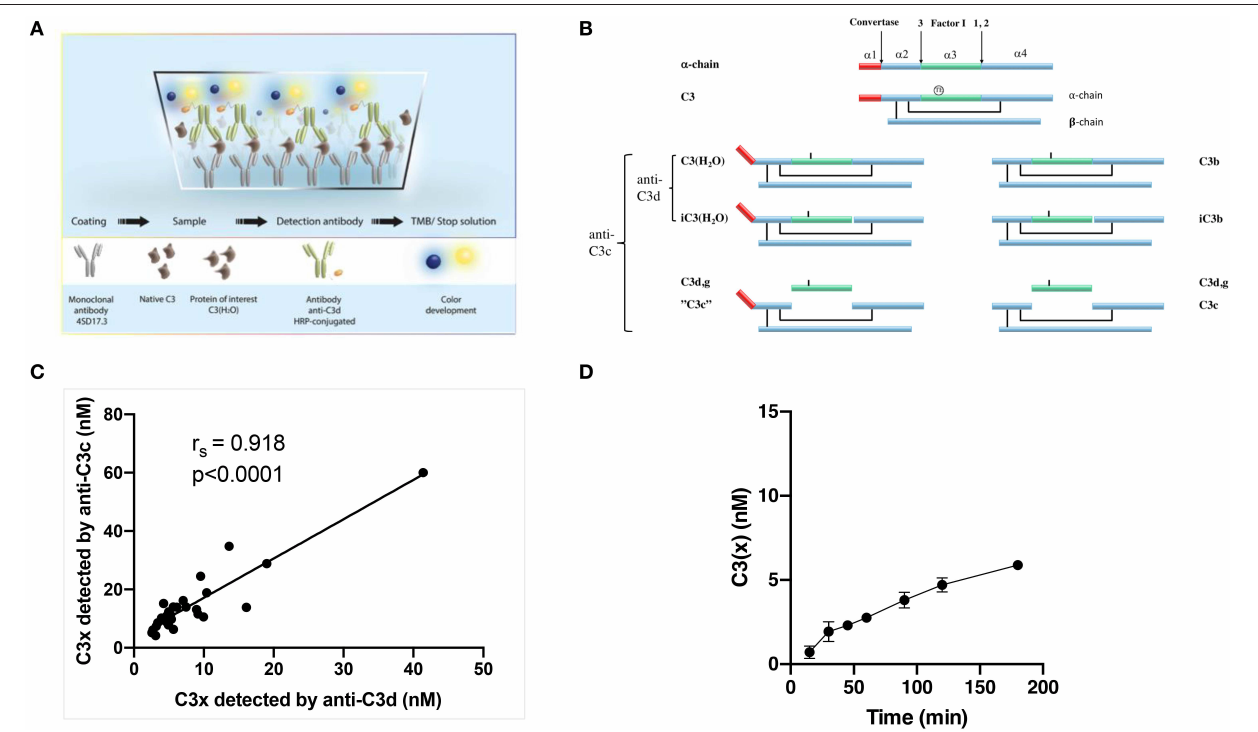
FIGURE 2 | (A) An illustration of the newly developed assay to measure non-proteolytically activated C3. (B) Schematic linear representation of native C3 [ α -chain alone with indicated cleavage sites for convertases and Factor I appointed 1–3 (top of the figure) and the intact C3 molecule with a mark for the position of the thioester (below)], non-proteolytically activated C3 i.e., C3(x) (left) and C3 activated by convertases i.e., C3b (right) and their degradation fragments. The figure is adapted from Ekdahl et al. (25) with permission from the publisher. (C) Correlation between measured levels of C3(x) using anti-C3d or anti-C3c polyclonal antibodies for detection. (D) Measured C3(x) formation in plasma over time from 0 to 180min.